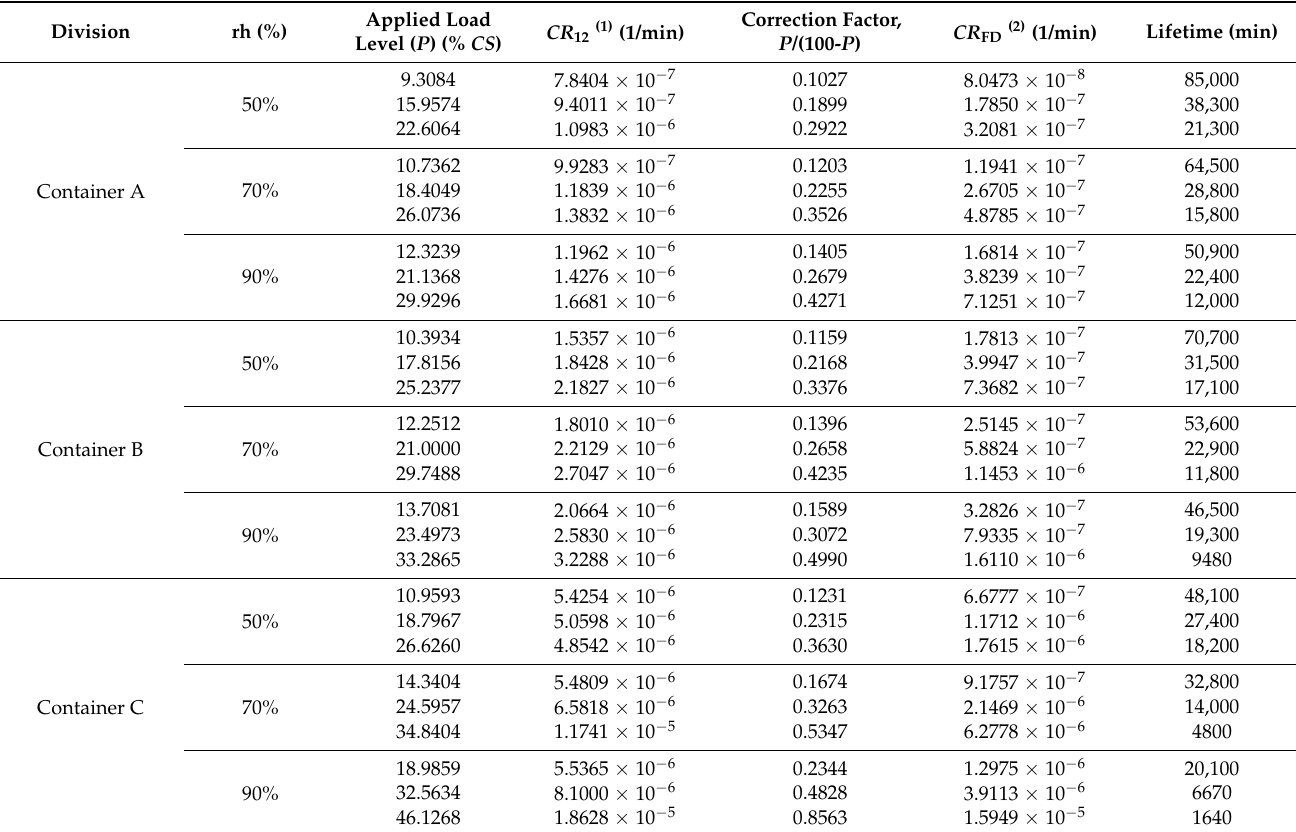
Table 7. Lifetime prediction results of the target shipping containers [10].